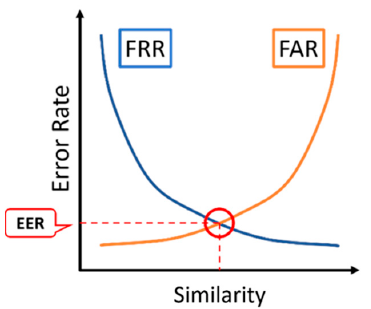
Figure 6. Ideal FRR–FAR curves image and EER crossing point.